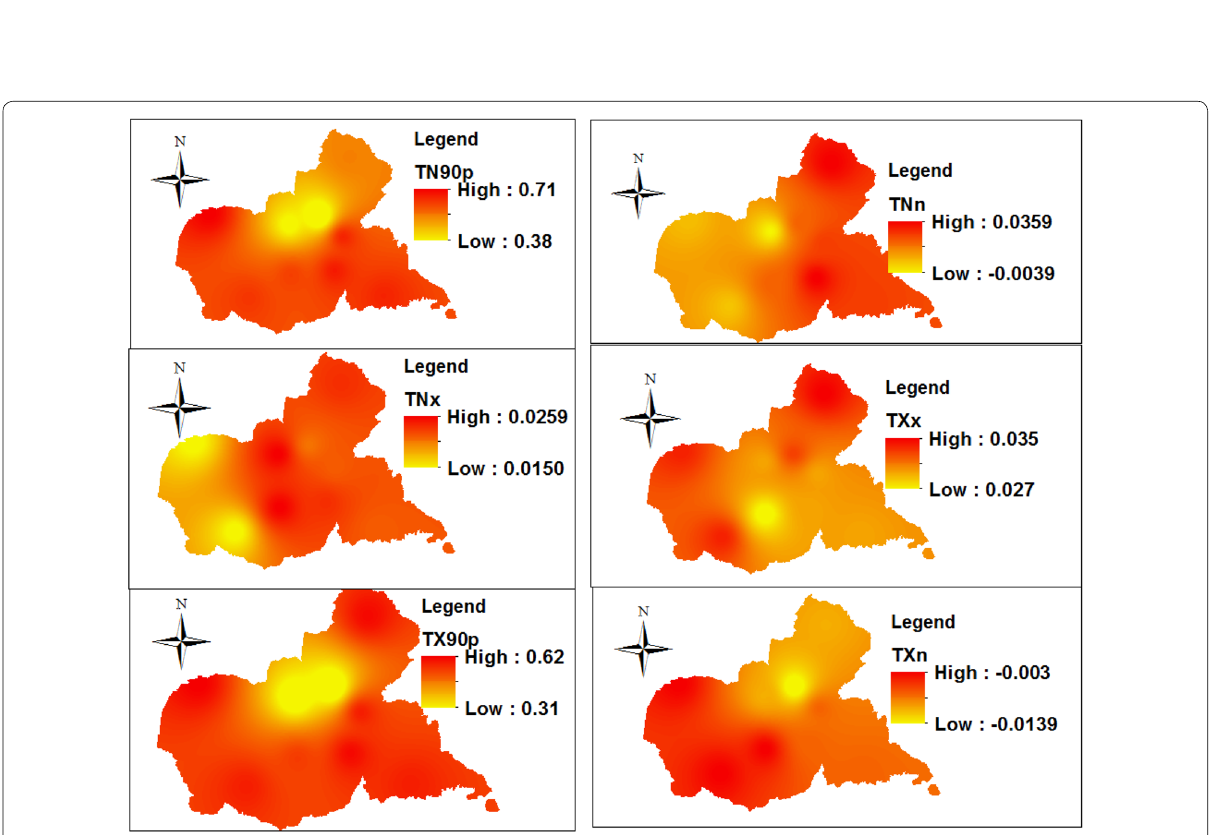
Fig. 9 Extreme temperature indices; TXx (maximum value of monthly maximum temperature), TNn (minimum value of monthly minimum temperature), Tmin (mean of minimum temperature), Tmax (mean of maximum temperature of nine stations from 1983 to 2016 in Western